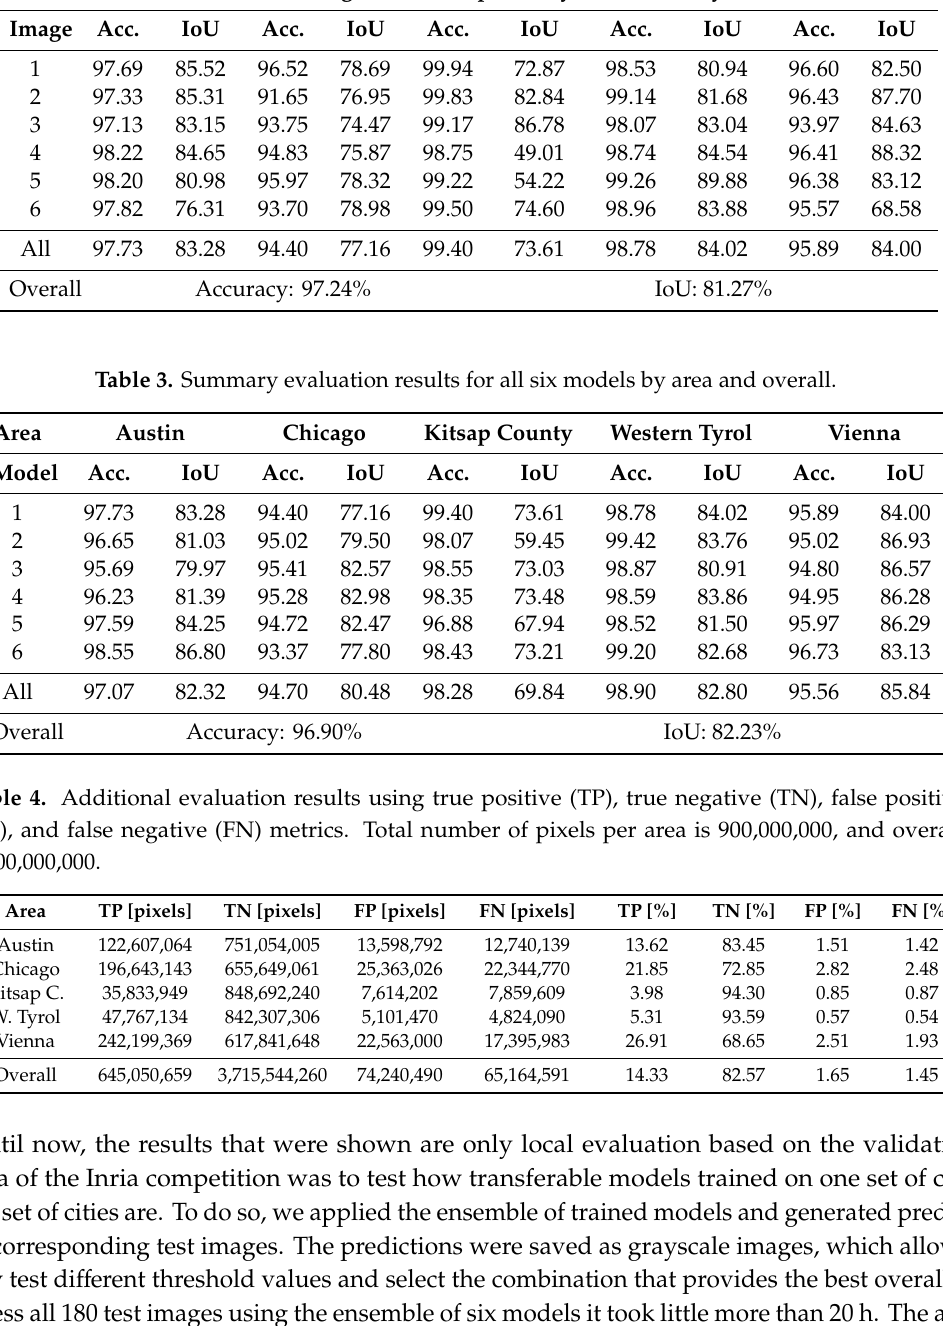
Table 2. Detailed evaluation results on the validation images (1–6) for the first model. Area